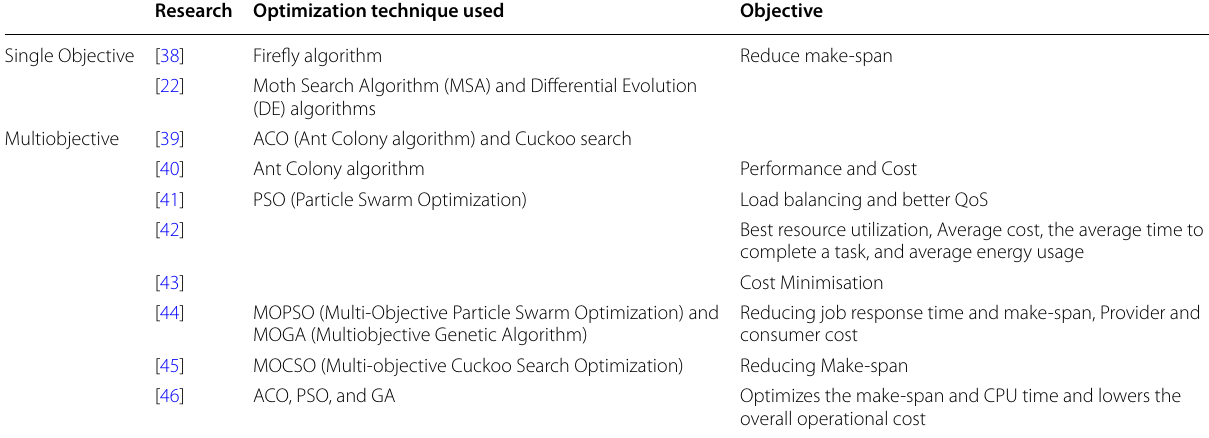
Table 1 Meta-Heuristics used in cloud computing Research Optimization technique